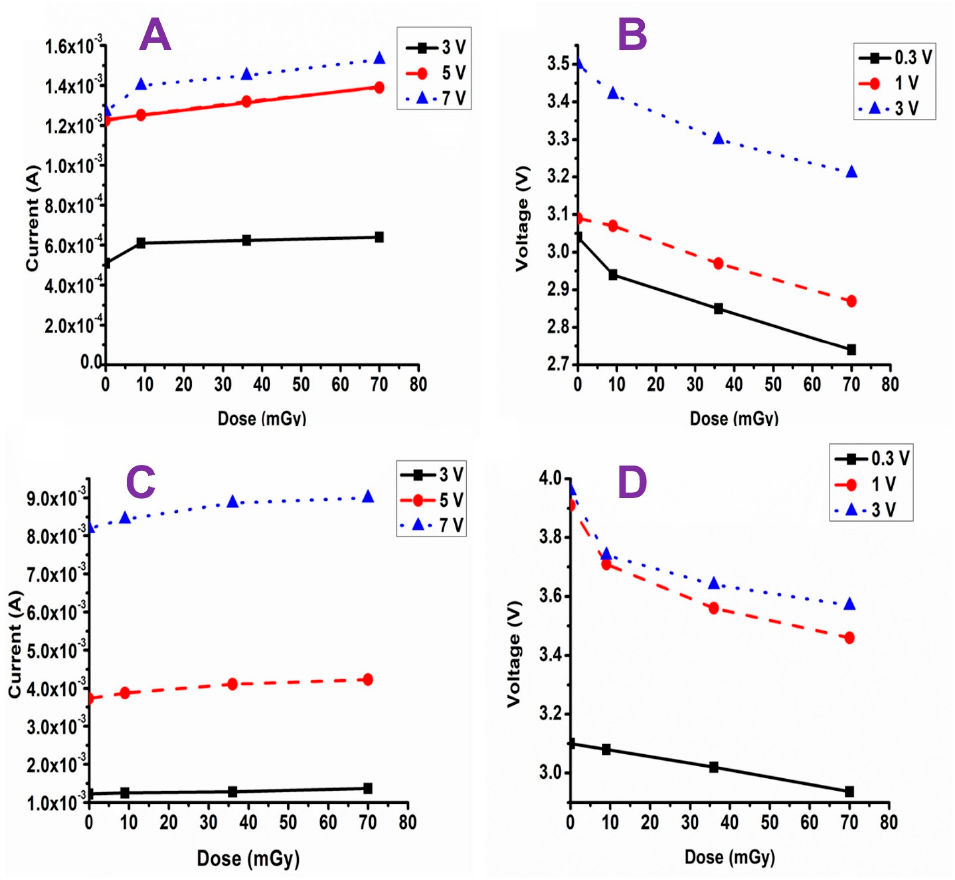
Figure 8. The effect of bias voltage on ( A , C ) current vs. dose and ( B , D ) voltage vs. dose for AZO thick film and AZO disk type, respectively.